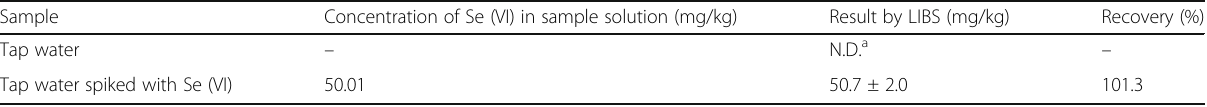
Table 2 Analysis of Se (VI) in sample with Se (VI) added to tap water Sample